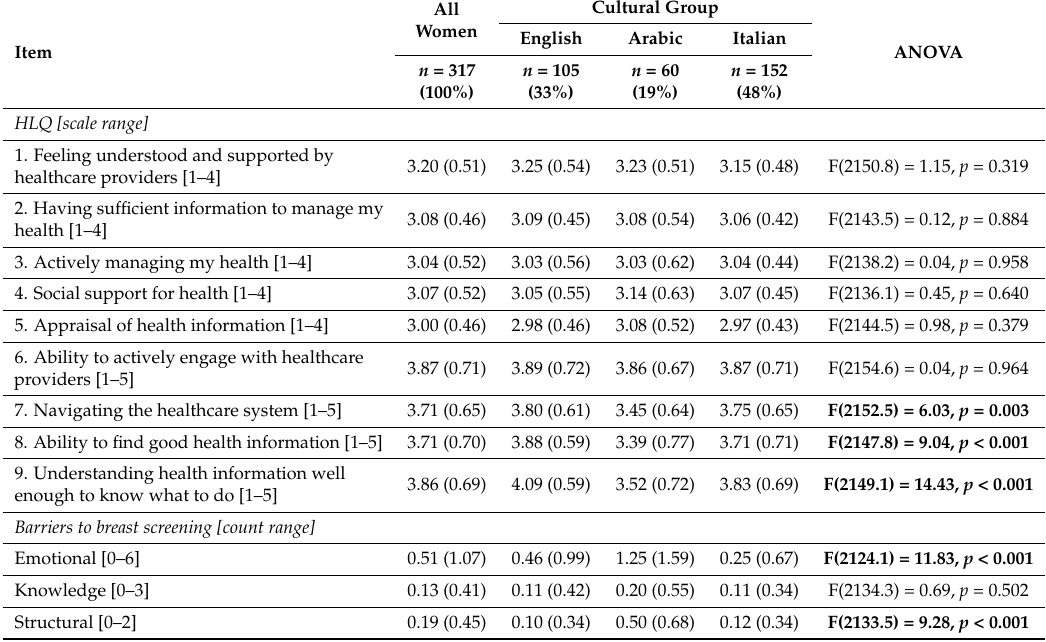
Table 4. Descriptive statistics for the HLQ scales and barriers to breast